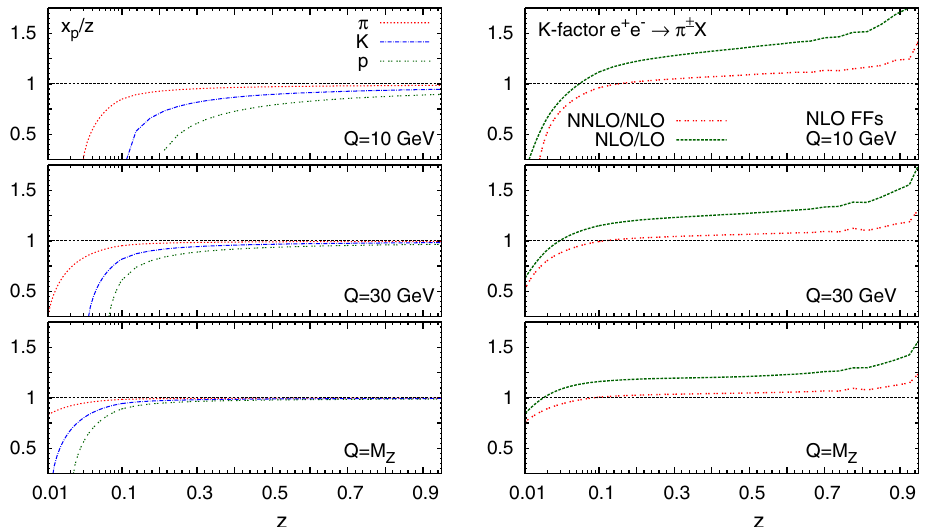
√ Fig. 2 Left the scaling variable ratio x p / z as a function of z , at three s . The K -factors have been computed with at the same three values of √ s , for pions, kaons and protons. Right the SIA representative values of fixed NLO charged pion FFs from the DEHSS determination [17] ( N m LO )/ F h ( N m − 1 LO ) for m = 1 , 2, K -factor, defined as the ratio F h 2 2 included in the perturbative expansion of splitting and coef- ficient functions. To illustrate the perturbative convergence of the SIA structure function in Eq. (2.3), we show in Fig. 2 √ s the SIA K -factors at three representative values of